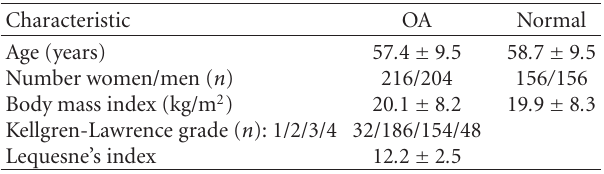
Table 1: Clinical characteristics of the osteoarthritis patients and control